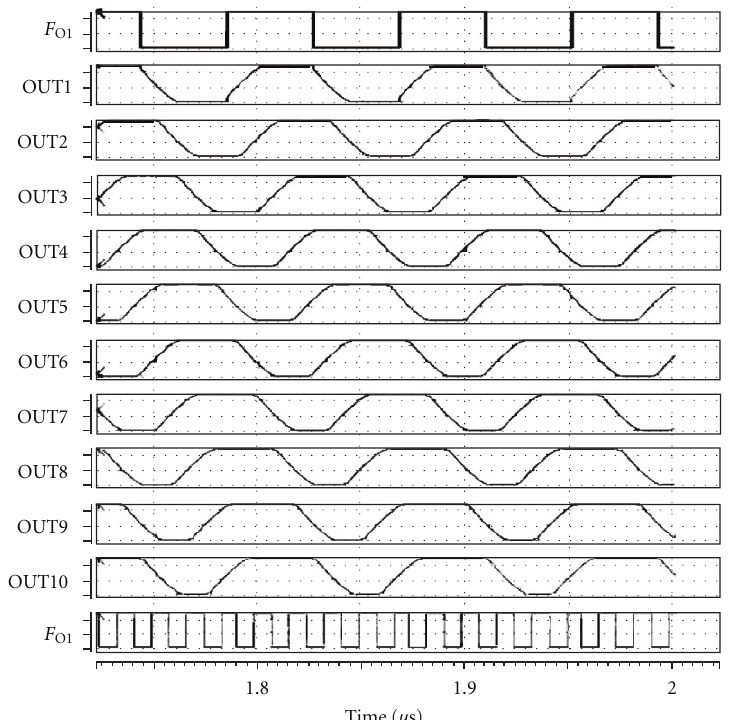
Figure 26: Postlayout simulation result of VCDL output signals from DLL1 settling operation. The simulation condition is tt/1.2V/25 ◦